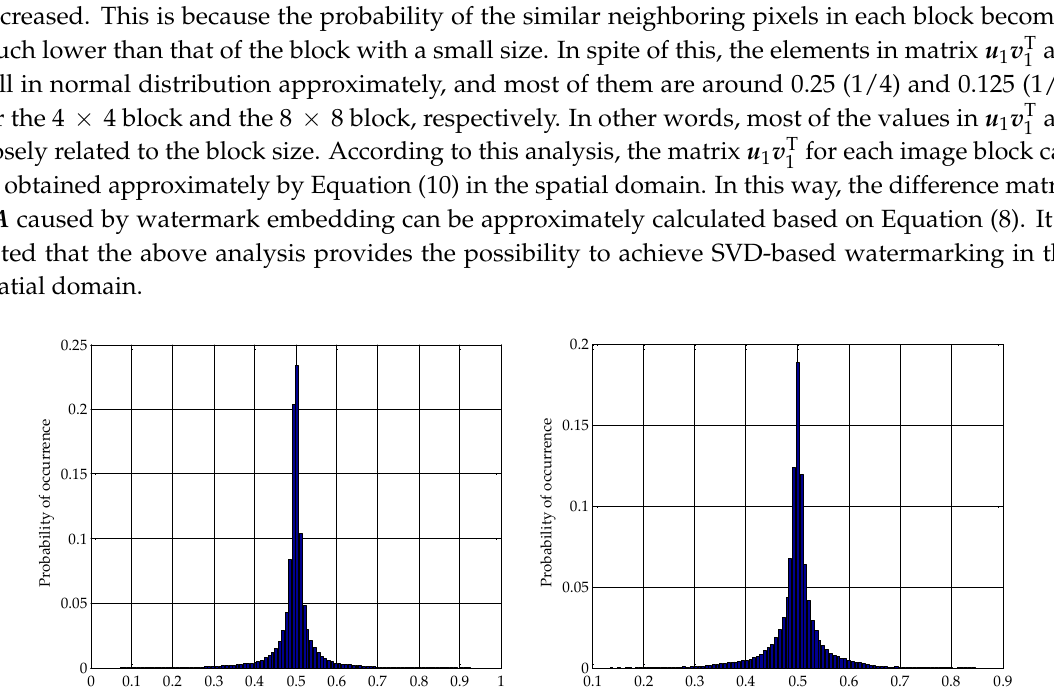
Figure 1. Frequency distribution histogram of the values in u 1 v T ( b ) Image Barbara.